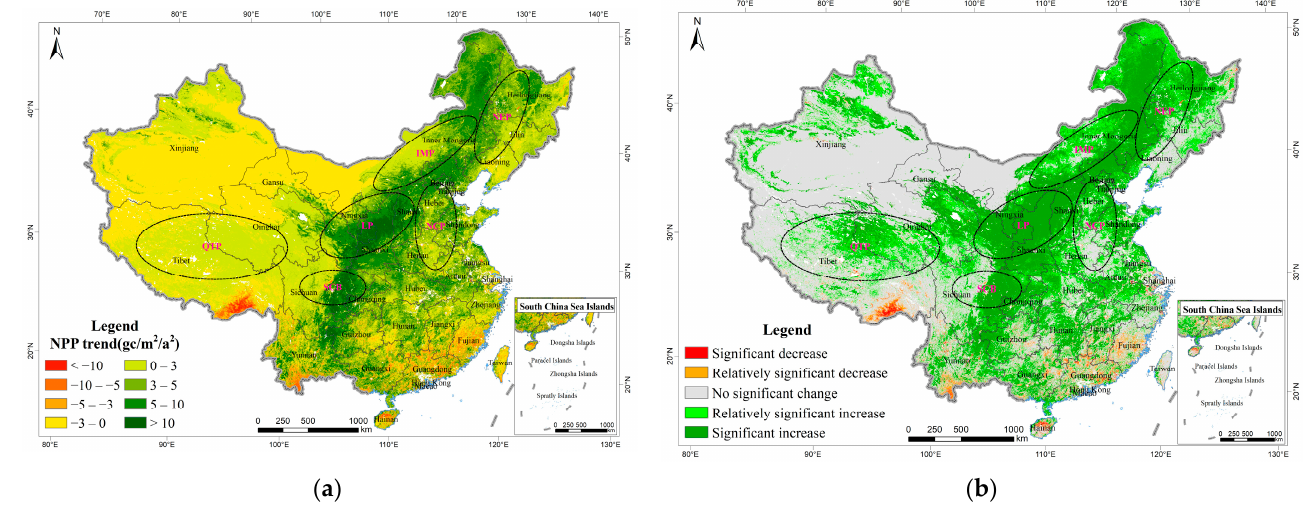
Figure 8. The 2000–2019 national vegetation NPP trend ( a ) and its significance test ( b ) (IMP: Inner Mongolia Plateau, NEP: Northeast Plain, QTP: Qinghai-Tibet Plateau, LP: Loess Plateau, NCP: North China Plain, SCB: Sichuan Basin). Table 6. Statistical table for the significance test of the NPP trend.